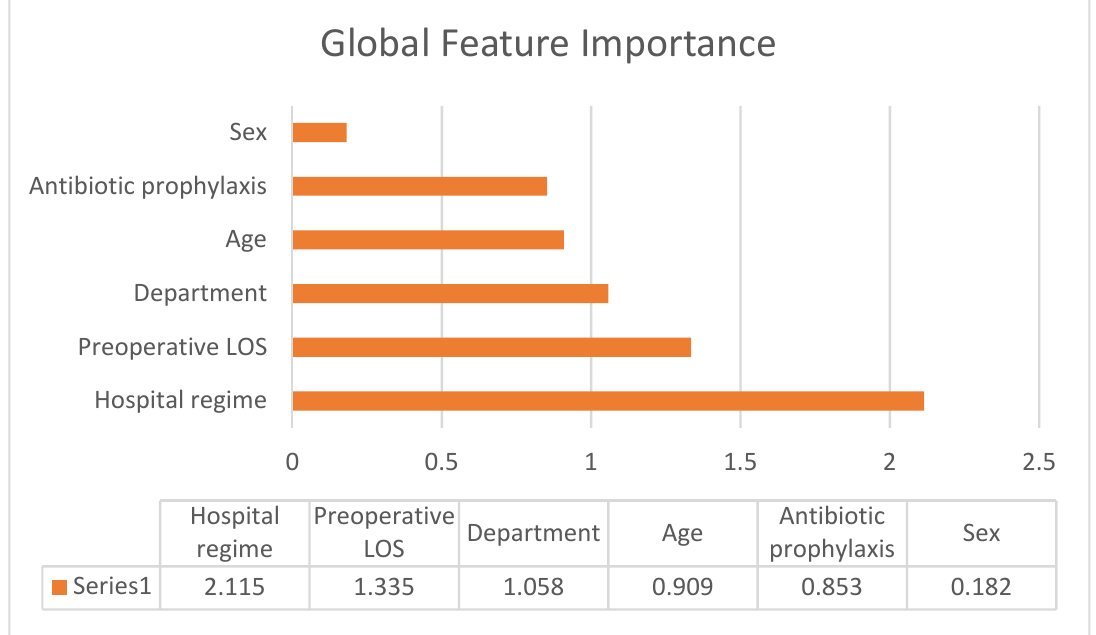
Figure 1. Global Feature Importance.